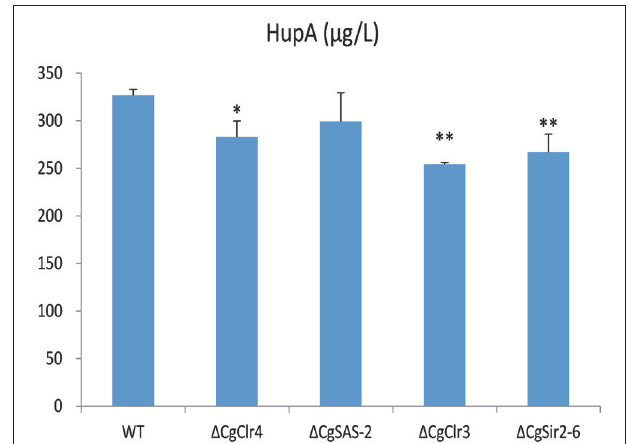
FIGURE 10 | Comparison of HupA production from culture extracts from wild type (WT) C. gloeosporioides Cg01 and 1 CgClr4 , 1 CgSAS-2 , 1 CgClr3 , and 1 CgSir2-6 mutants. The experiment was performed in triplicate. Mean values and standard deviations are given. Asterisks above the bars denote significant differences in the measurements of the indicated strains compared to the WT. * p < 0.05; ** p < 0.01.